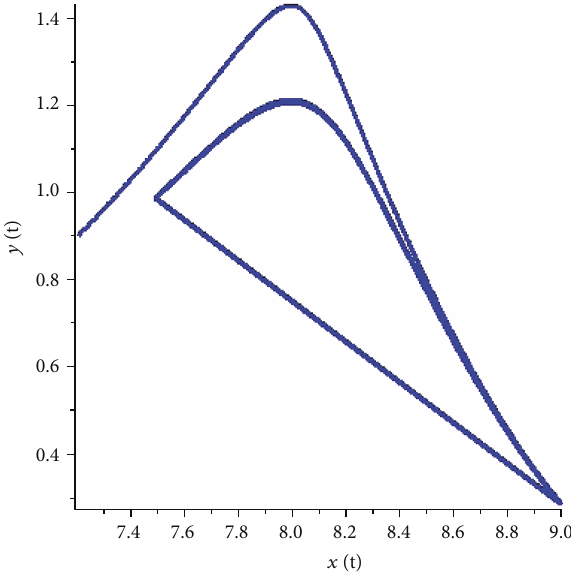
Figure 19: There exists an order-1 periodic solution in system (16) with q 1 = 1/6 , p = 0 9 , and τ = 0 7 .